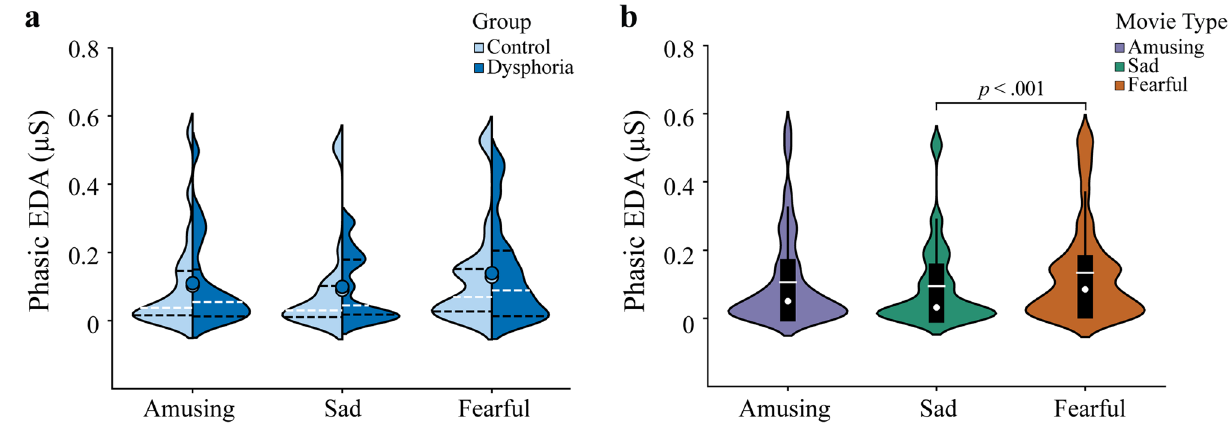
Figure 1. Violin plots for the mean phasic EDA values averaged over the timepoints separately for each movie type. For both ( a,b) , violin plot outlines illustrate the distribution of EDA estimates using kernel probability density with the bandwidth of 0.2. Wider area of the violin plot represents a higher probability of the values that the EDA take on, and the thinner area corresponds to a lower probability. Please note that the negative values in the violin plot are the estimations of values of the EDA data, which is caused by the use of kernel density estimation. ( a ) The mean phasic EDA values to each movie type in each group (no significant group differences). Each side of the violin corresponds to a different group. Dots denote mean of the EDA. Horizontal white dotted lines show median of the EDA and horizontal black dot lines represent the interquartile range (IQR) of the EDA. ( b ) The mean phasic EDA values to each movie type averaged over the control and dysphoric groups. White dots on the violin plots show the median of the EDA and horizontal white lines represent the mean of the EDA. The black bars in the centre of violins denote the IQR of the EDA. The black lines stretched from the bars show the lower and upper adjacent values (1.5 times the IQR) of the EDA,